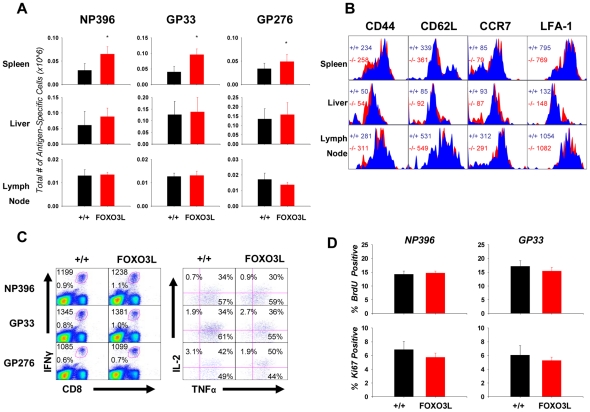
Loss of FOXO3 in the T cell compartment enhances the quantity of memory CD8 T cells without decreasing their quality.(A) At 180 days after LCMV infection, mononuclear cells from spleen, liver and lymph nodes of +/+ and FOXO3L mice were collected and stained with anti-CD8 and MHC-I tetramers. Bars represent data from 2 independent experiments with 4–7 mice/group/experiment; error bars represent the SEM and * indicates statistical significance at p<.05. (B) At 180 days PI, splenocytes were stained with anti-CD44, anti-CD62L, anti-CCR7 and anti-LFA-1 along with anti-CD8 and MHC-I tetramer. Representative plots for CD44, CD62L, CCR7 and LFA-1 are gated on tetramer-binding CD8 T cells. The numbers represent the MFI for the indicated protein. (C) Cytokine production by LCMV-specific memory CD8 T cells from +/+ and FOXO3L mice. Representative dot plots (left) are gated on total lymphocytes. The top numbers indicate the MFI for IFNγ while the bottom number in the plot indicates the percentage of total splenocytes that are CD8 and IFNγ positive. Dot plots (right) represent the percentage of IL-2 and/or TNFα producing cells among IFNγ+ve CD8 T cells. The plots represent data from 1 of 2 independent experiments with 4–7 mice/group/experiment. (D) +/+ and FOXO3L mice were infected with LCMV and given a BrdU injection at 120 days PI and administered BrdU in drinking water between days 120–128 PI (top). At the end of the BrdU pulse, splenocytes were stained with anti-CD8, MHC-I tetramers and anti-BrdU (top) or anti-Ki67 (bottom). The percentage of BrdU or Ki67 positive cells amongst tetramer positive CD8 T cells was determined by flow cytometry. Bars represent data from at least 5 mice/group.